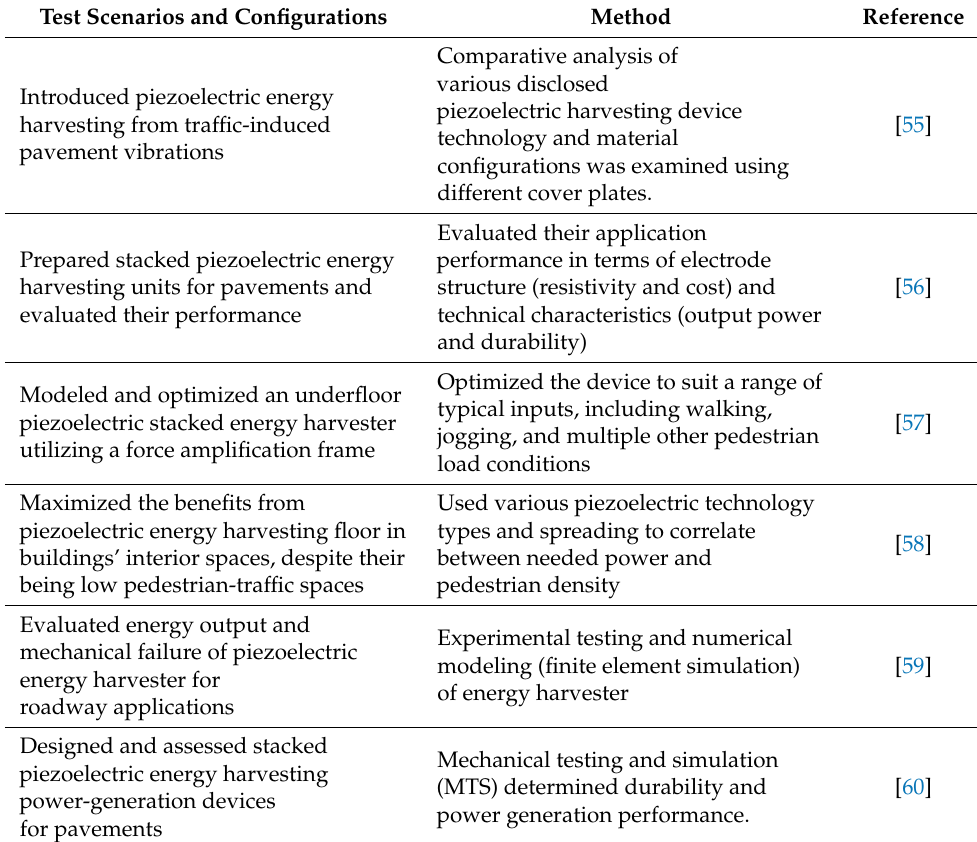
Table 1. Laboratory and field studies of piezoelectric energy